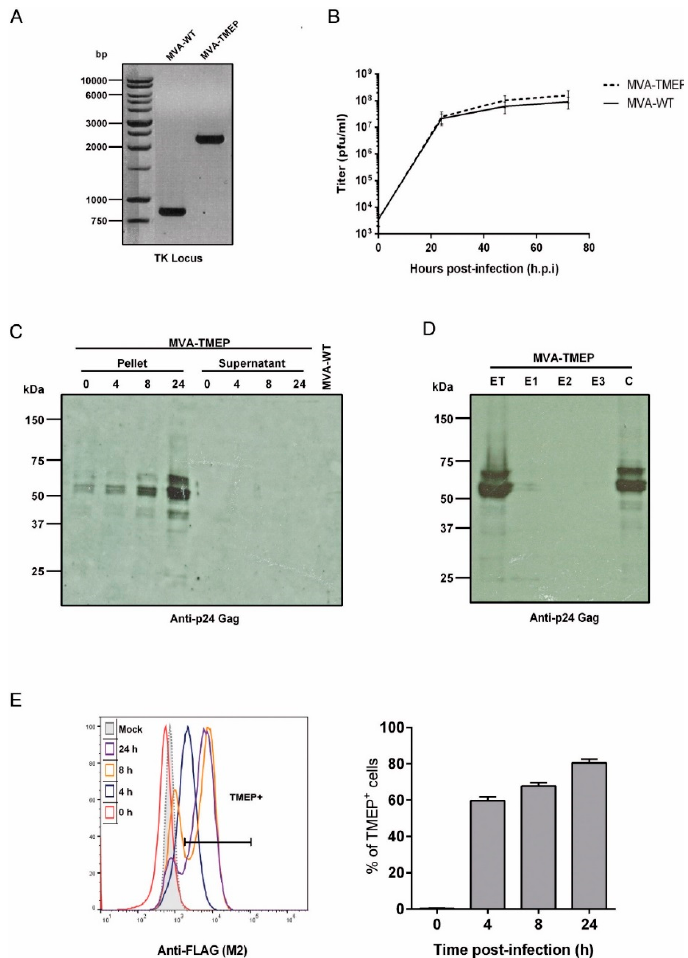
Figure 1. In vitro characterization of modified vaccinia virus Ankara (MVA)-TMEP recombinant virus. ( A ) Confirmation of TMEP-B insertion by PCR analysis. DNA was extracted from DF-1 cells infected at 5 pfu / cell with MVA-wild-type (WT) or MVA-TMEP viruses. Primers thymidine kinase (TK)-R and TK-L spanning TK flanking regions were used for the analysis of the TK locus by PCR. In parental MVA-WT, a product of 853 bp corresponding to parental TK locus is obtained while in MVA-TMEP a unique product of 2292 bp is observed. ( B ) Analysis of virus growth. Monolayers of chicken embryo fibroblast (CEF) cells (permissive cell line) were infected at 0.01 pfu / cell with MVA-WT or MVA-TMEP viruses. At di ff erent times post-infection (0, 24, 48 and 72 h), cells were harvested and viral titers were determined by immunostaining plaque assay in DF-1 cells. Data points represent titers as mean ± SD of n = 2 experiments. ( C ) Time-course expression of TMEP-B protein by Western-blot analysis. DF-1 cells were infected at 5 pfu / cell with MVA-WT or MVA-TMEP viruses. At di ff erent times post-infection (0, 4, 8 and 24 h), cells were harvested and cellular pellets and supernatants were processed as described in Materials and Methods, fractionated by 8% SDS-PAGE and the expression of TMEP-B protein was analyzed by Western-blot using the rabbit polyclonal anti-p24 Gag serum. ( D ) Fractionation of viral proteins and localization of TMEP-B protein within purified MVA-TMEP virions. MVA-TMEP sucrose-purified virions were sequentially disrupted by detergent treatment and the di ff erent fractions were obtained as described under Materials and Methods. The unfractionated lysate virions (total extract, ET) and the di ff erent collected fractions (E1, E2, E3 and C) were analyzed by Western-blot using anti-p24 Gag antibody. ( E ) Analysis of TMEP-B expression by flow cytometry. HeLa cells infected at 5 pfu / cell with MVA-WT or MVA-TMEP viruses for 0, 4, 8 and 24 h were processed for flow cytometry as described under Materials and Methods using 5 µ g / mL of monoclonal antibody anti-FLAG. Geometric Mean Fluorescence Intensity (gMFI) values (left panel) and percentages of FL2 + cells (right panel) on the “live cells” gate are